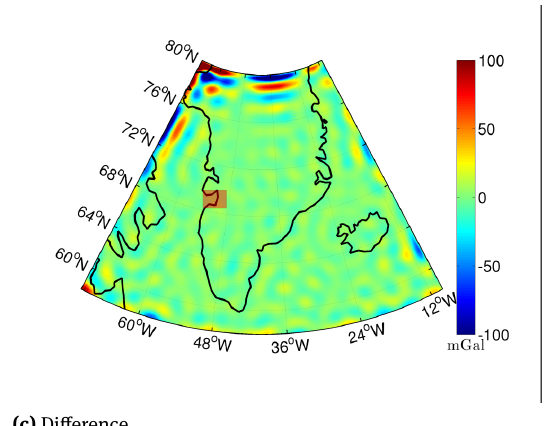
Fig. 3. Comparison of predicted gravity anomaly residuals found using LSC (a) and the RPM (b) respectively. Area of Jakobshavn Isbræ glacier is outlined red in the difference (c). The observations used are acquired in December 2009.